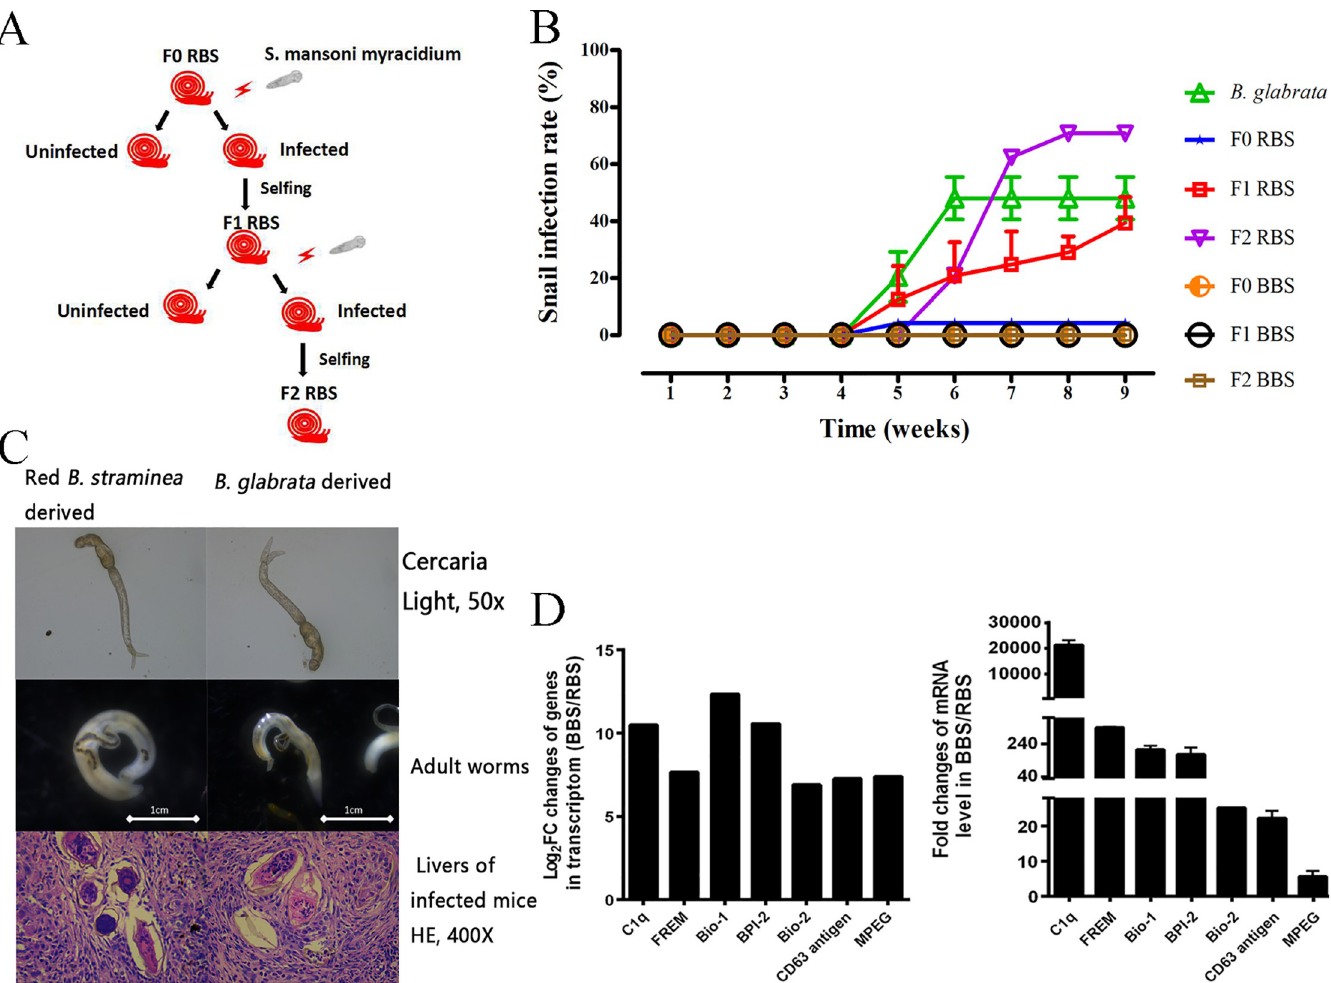
Fig 8. The susceptibility of B . straminea to S . mansoni . (A) Selection procedures of susceptible RBS. (B) Positive rates of B . glabrata , different generations (F0, F1, F2) of RBS and BBS infected by S . mansoni . (C) Cercariae (top), adult worms (middle) and HE stained pathological sections (mice liver) (down) of S . mansoni derived from both B . straminea and B . glabrata . (D) Analysis of differentiated expressed genes (DEGs) involved in the complementary system of BBS (black B . straminea ) when comparing to F2RBS (F2 generation of selected red B . straminea ). Left panel, expression levels (Log2FC) of DEGs involved in complementary system of BBS when comparing to RBS in transcriptome. Right panel, RT-PCR results of DEGs involved in complementary system of BBS when comparing to F2RBS. FREM: fibrinogen- related molecule. Bio-1: biomphalysin like protein 1, BPI-2: bactericidal permeability-increasing protein 2, Bio-2: biomphalysin like protein 2, MPEP: macrophage expressed